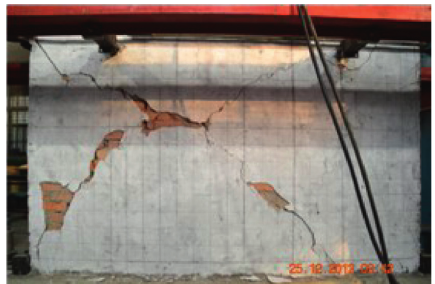
Figure 5: MLQT-1 collapse